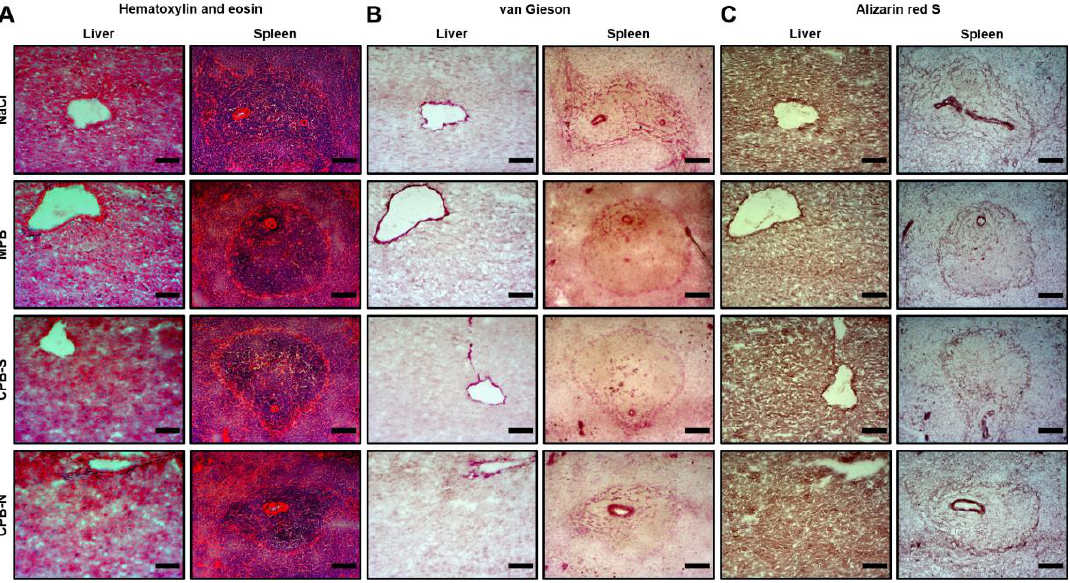
Figure 3. Histological analysis of the liver and spleen of Wistar rats treated with NaCl, MPB, CPB-S, or CPB-N according to the indicated protocol. (A) Hematoxylin and eosin, (B) van Gieson, and (C) alizarin red S stainings show the absence of cellular damage, fibrosis, and mineralization, respectively. Scale bar = 100 µm, 200× magnification.